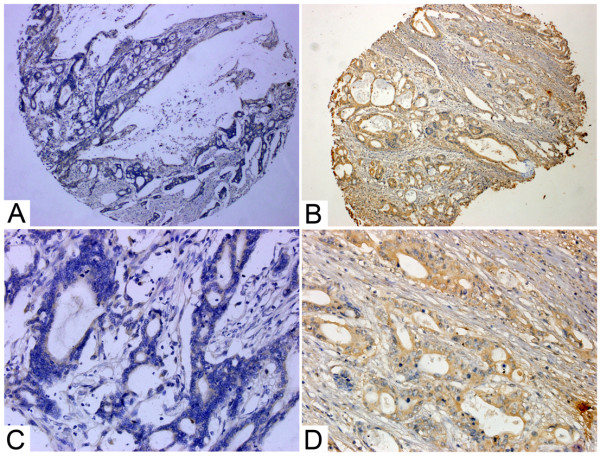
Immunohistochemical staining for klotho in gastric cancer tissues, ×400 magnification. (A, C) negative expression of klotho in gastric cancer tissue, A: magnification × 100, C: magnification × 400; (B, D) positive expression of klotho in gastric cancer tissue, B: magnification × 100, D: magnification × 400.